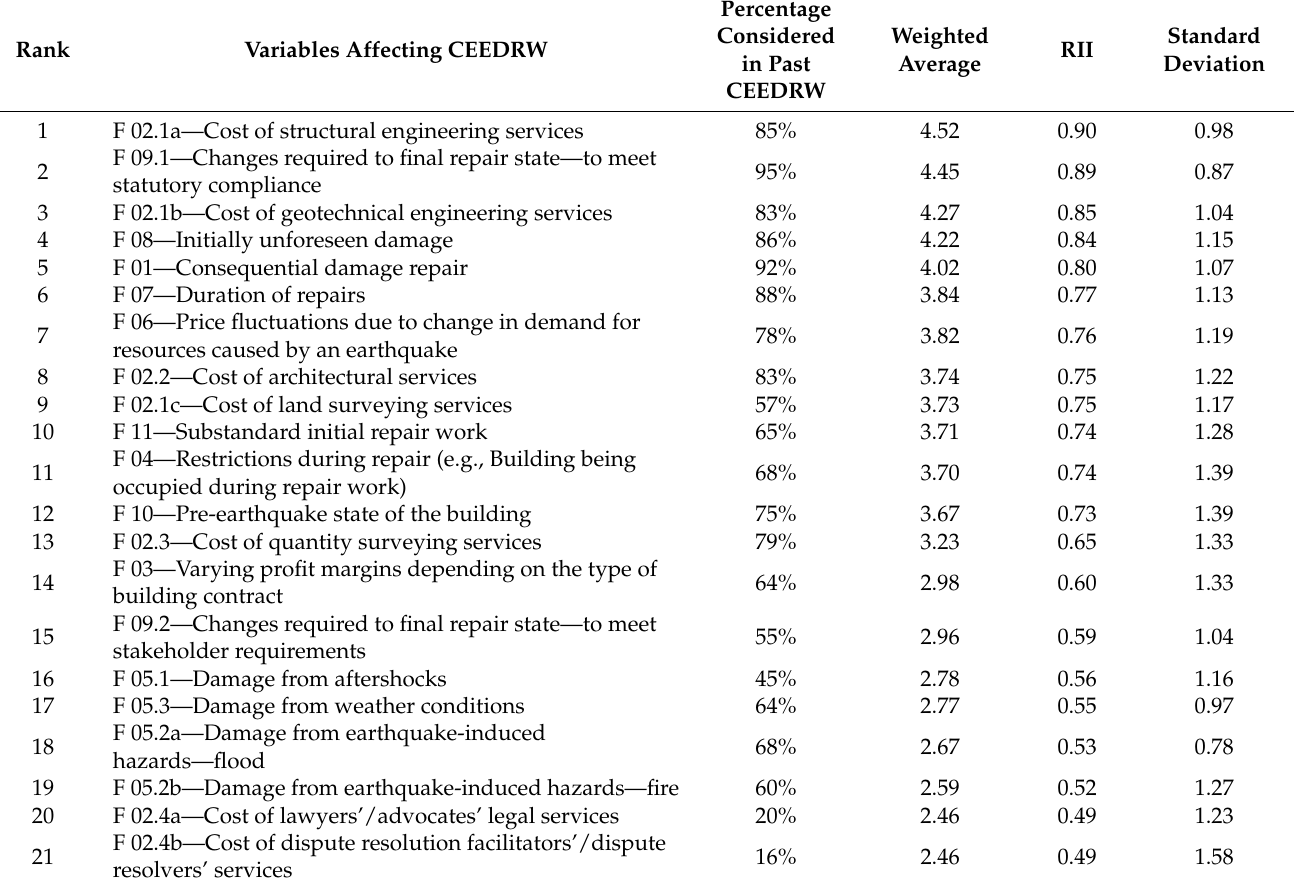
Table 5. Significance of the variables affecting CEEDRW according to the weighted